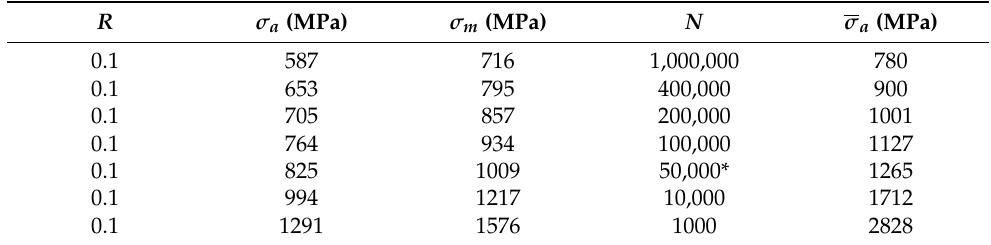
Table 2. Experimental data of the polished surface case of Tanrikulu and Karakuzu